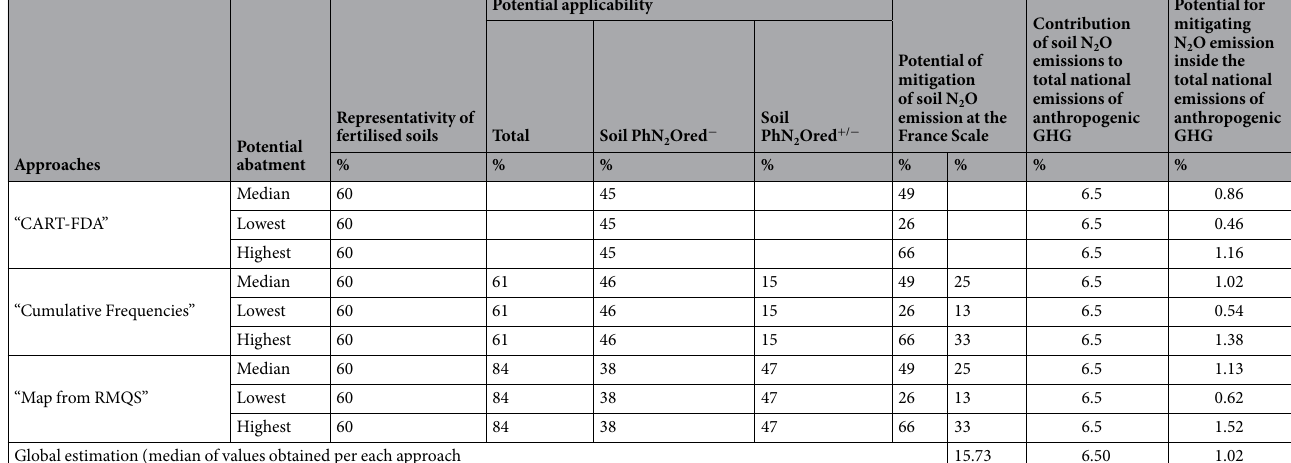
Table 1. Estimated benefit of liming as a method for N 2 O emission mitigation obtained by the